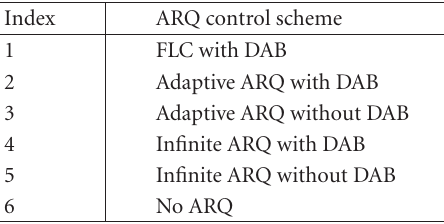
Figure 5: Mean number of transmissions by ARQ with DAB scheme, according to channel conditions. Table 2: Various ARQ schemes applied in Figure